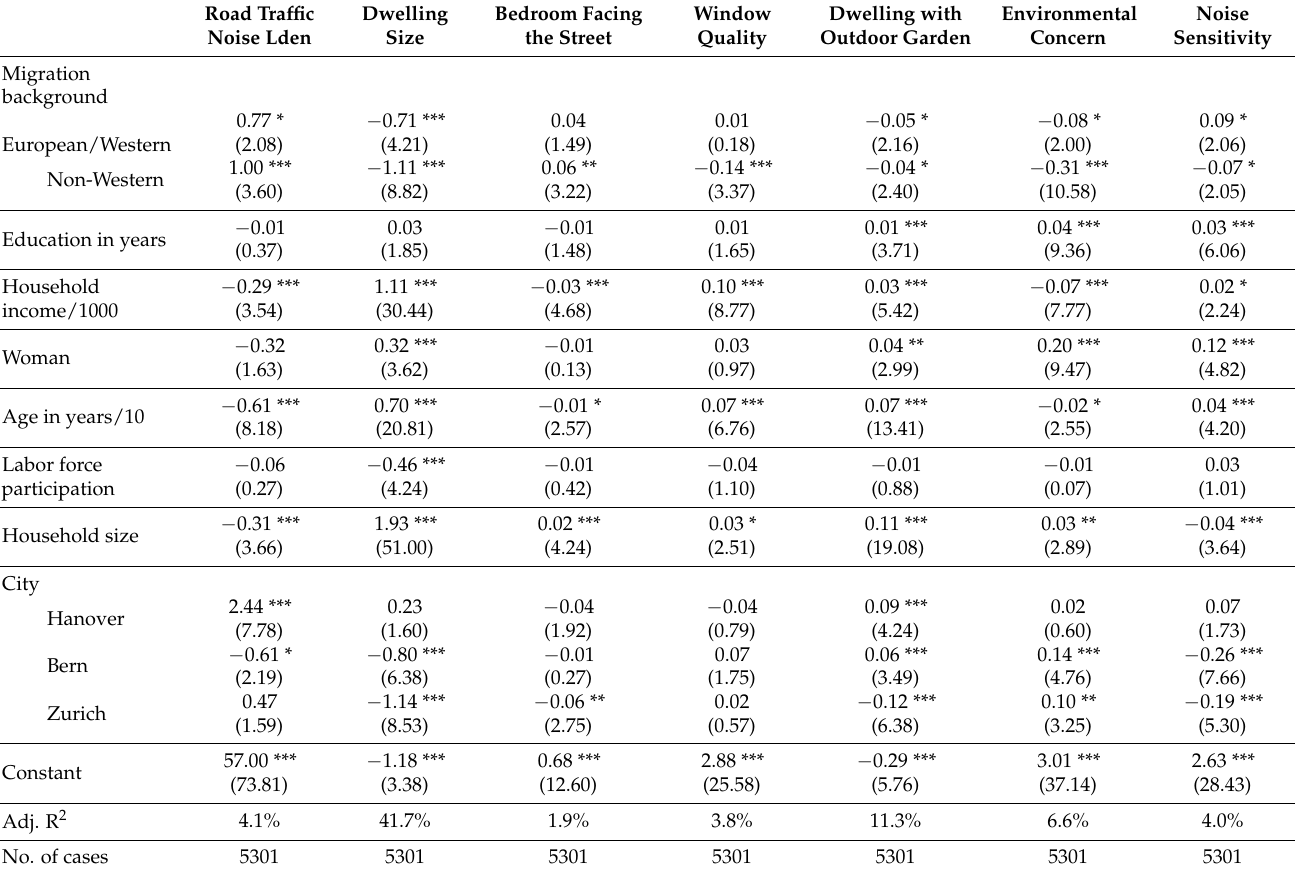
Table 3. Factors affecting noise exposure, housing attributes, and environmental susceptibility (OLS